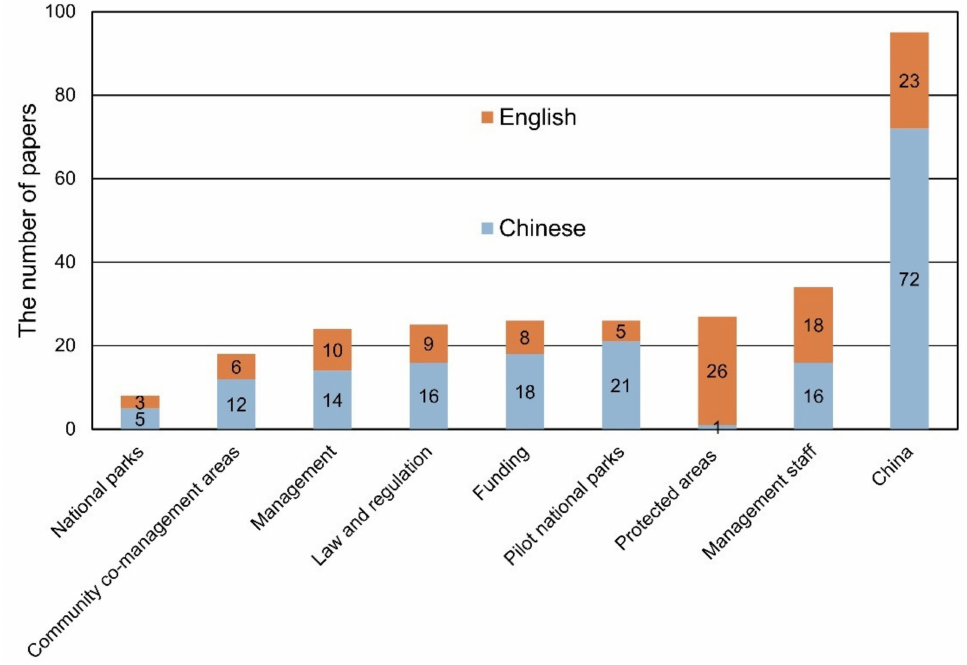
Figure 1. The number of papers analyzed for different